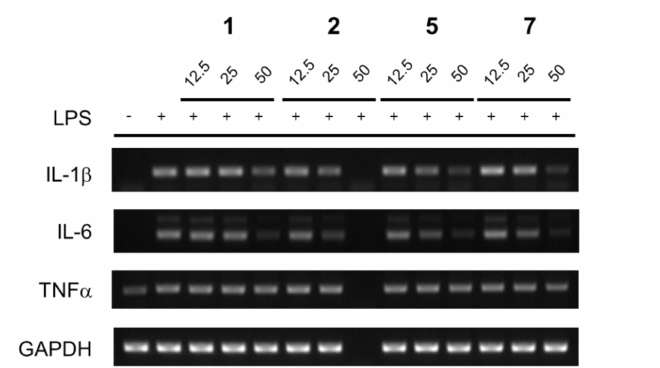
Figure 2. Inhibitory effects of 1 – 7 on pro-inflammatory cytokine production of activated macrophage cells. RAW 264.7 cells were treated with 1 µ g/mL LPS for 24 h in the presence of the indicated amounts (12.5~50 µ M) of compounds. Gene expression levels were analyzed by endpoint reverse transcriptase-polymerase chain reaction and 1.5% agarose gel electrophoresis. GAPDH was used as a